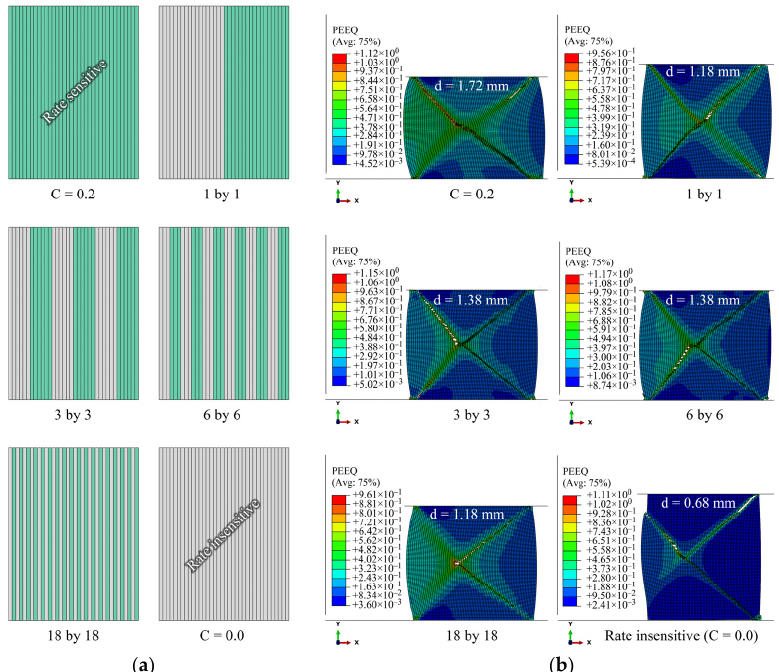
Figure 5. ( a ) Topographic profile of laminated layers in the cross-section of the ring, ( b ) effect of laminated layers on the fracture of the rings. The displacement level, d , at which the distribution of PEEQ is presented, is shown above each image.